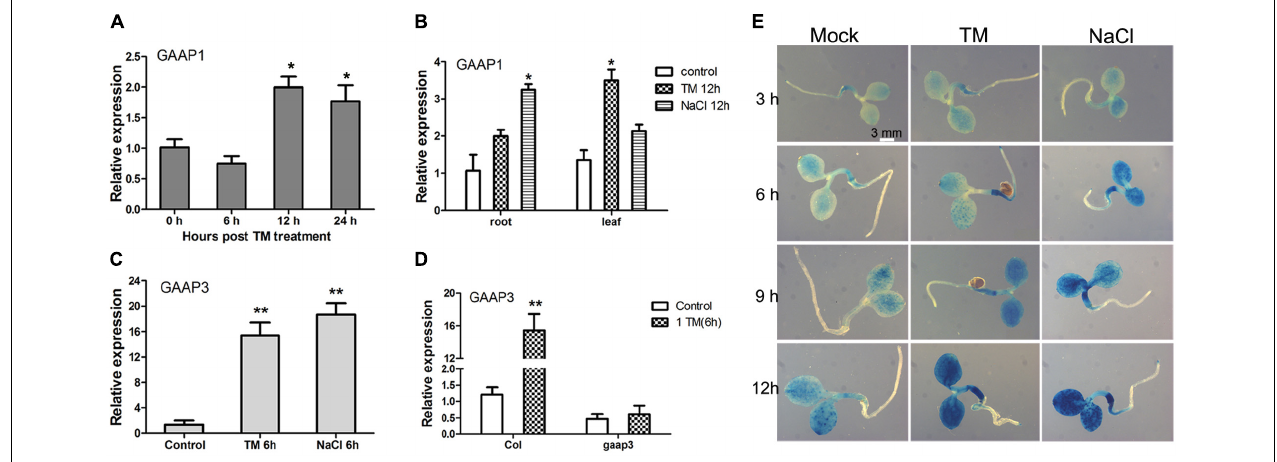
FIGURE 3 | Expression levels of GAAP1 and GAAP3 genes were induced by stress signals in Arabidopsis seedling. (A) Expression level of GAAP1 in 10-day-old plants in the presence of 0.5 µ g mL − 1 TM at different hours, as assayed by q-PCR. (B) Expression level of GAAP1 in the root or leaf of 10-day-old plants in the absence or presence of 0.5 µ g mL − 1 TM or 100 mmol L − 1 NaCl for 12 h, as assayed by q-PCR. (C) Expression level of GAAP3 in 4-day-old plants in the presence of 0.5 µ g mL − 1 TM or 100 mmol L − 1 NaCl for 6 h, as assayed by q-PCR. (D) Expression level of GAAP3 in 4-day-old seedlings of Col and gaap3 in the absence